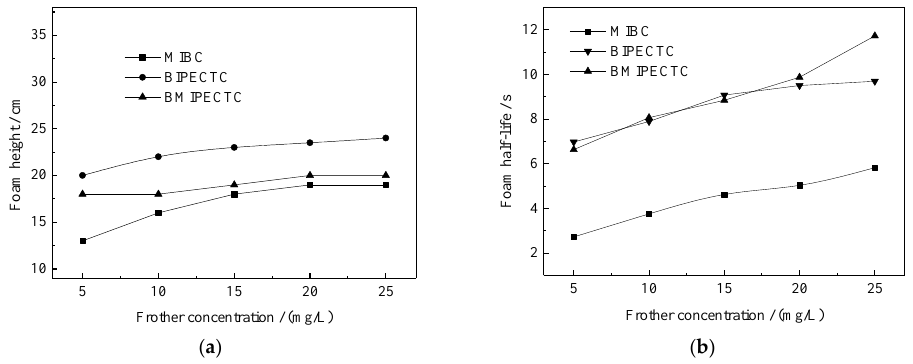
Figure 3. Maximum foam height and half-life as a function of the frother concentrations in aqueous solution. ( a ) Foam height; ( b ) Foam half-life.